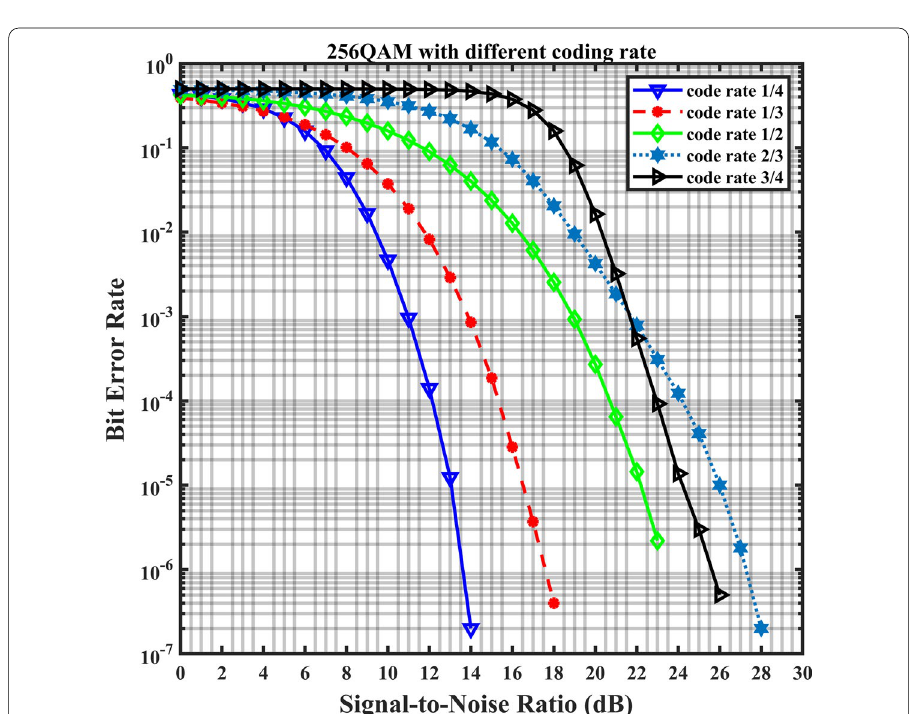
Fig. 18 BER versus SNR for 256 QAM for different coding rate. In this graph the performance of a combination of16 QAM with code rate of 1/4, 1/3, 1/2, 2/3, and 3/4 is shown. The performance is depicted as BER versus